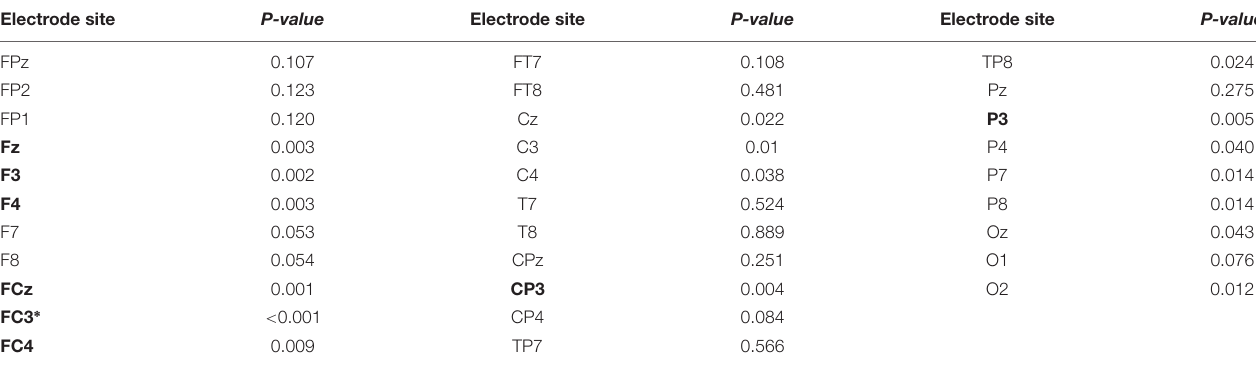
TABLE 2 | Results of the ANOVA investigating differences in PEIMF2 index between RP and NR groups at all electrode sites ( α = 0.01). Electrode site